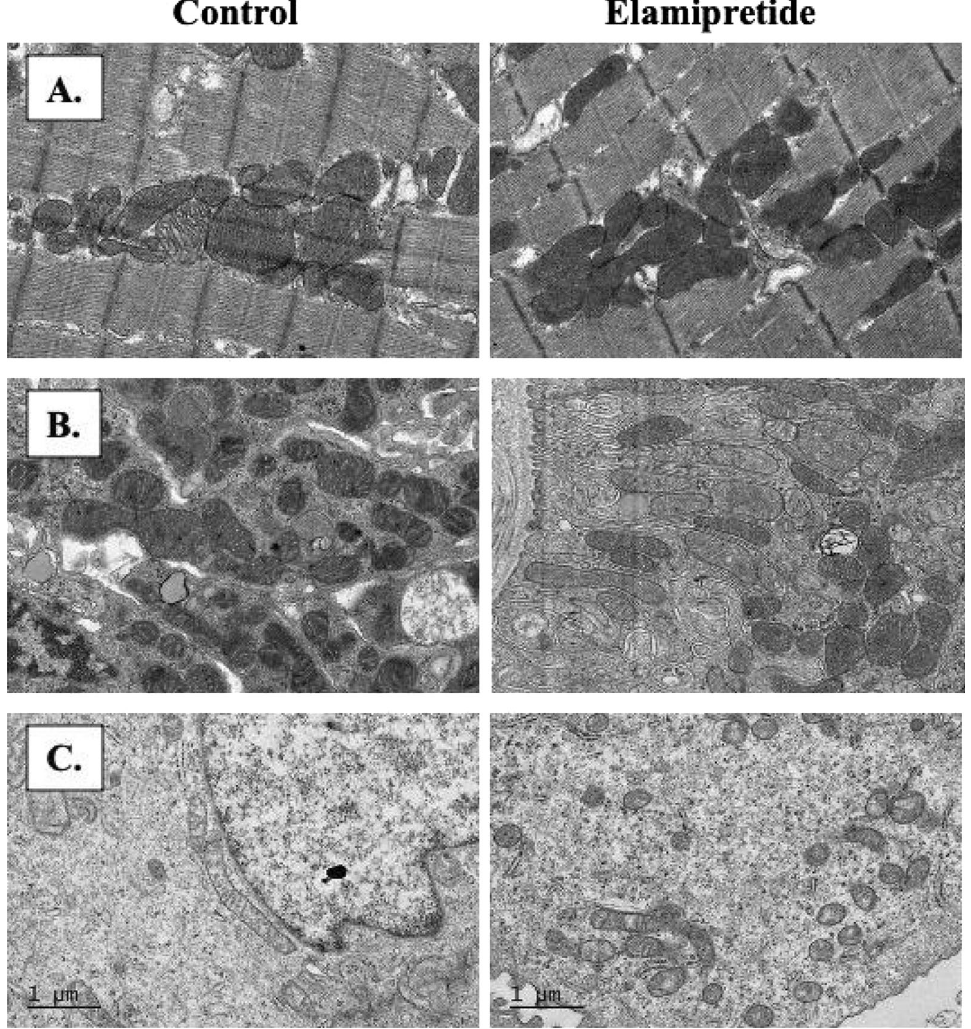
Figure 5. Electron microscopy images (4000x) of control and Elamipretide-treated pigs from the heart ( A ), renal cortex ( B ), and renal medulla ( C ). The mitochondrial shapes and architecture are preserved in the Elamipretide treated